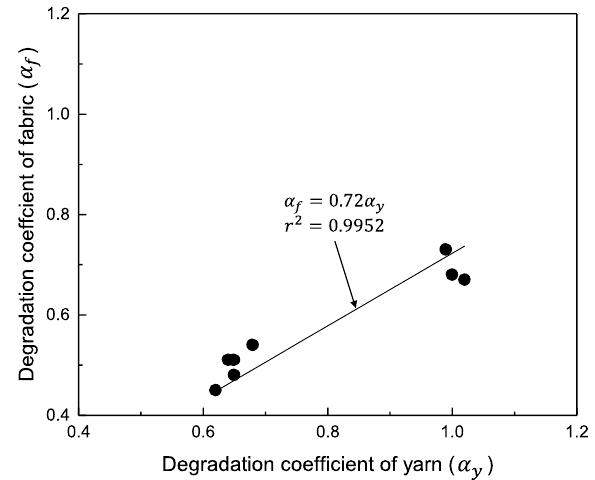
Figure 8. Relationship between degradation coefficient of yarn and fabric ( α y and α f ) by the blend of m-Aramid/p-Aramid based on Equation (3).